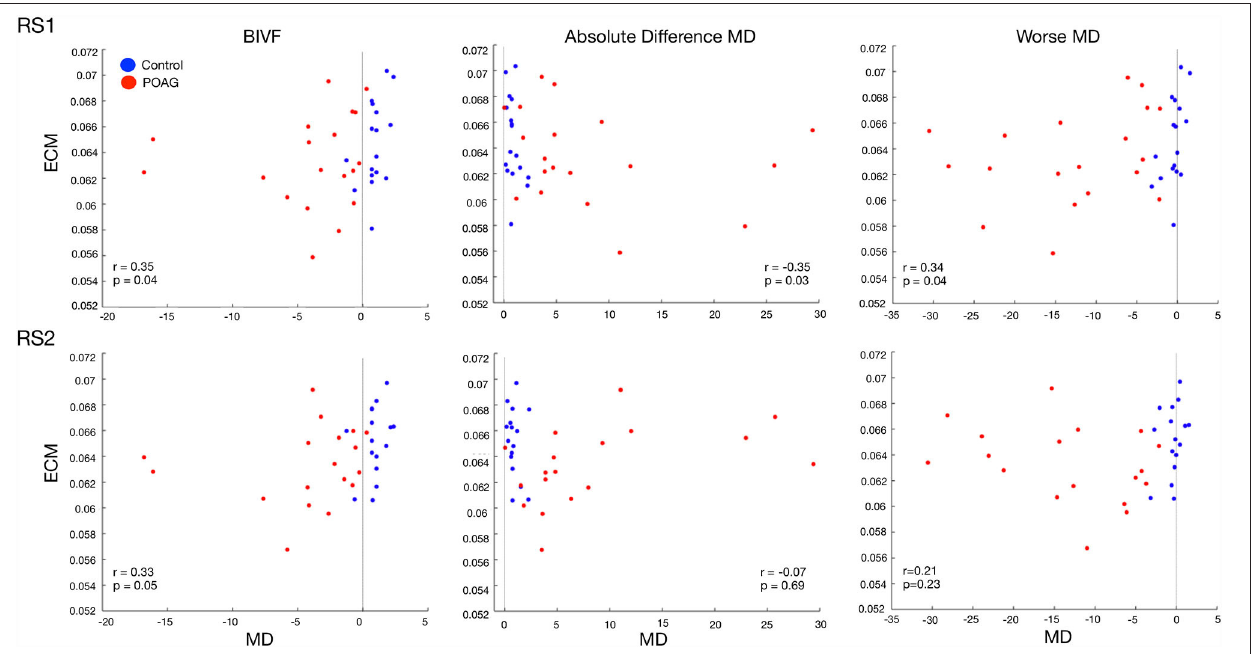
FIGURE 5 | Correlation between the EC value of the Lingual Gyrus and three behavioral visual field scores. The panels show the relation between the three visual field behavioral scores and the EC values of the Lingual Gyrus in RS1 (top row) and RS2 (bottom row). The black line indicates the zero for each behavioral score. The behavioral visual field scores are BIVF (Binocular Integrated Visual Field): the MD of the integrated visual field of the left and right eye, Absolute Difference MD: the absolute difference between the MD of the left and right eye, and the Worse MD: the lowest of the MD scores of either the left or right eye. The values reported in each panel are Spearman’s correlation between the behavioral score and the EC values and the associated